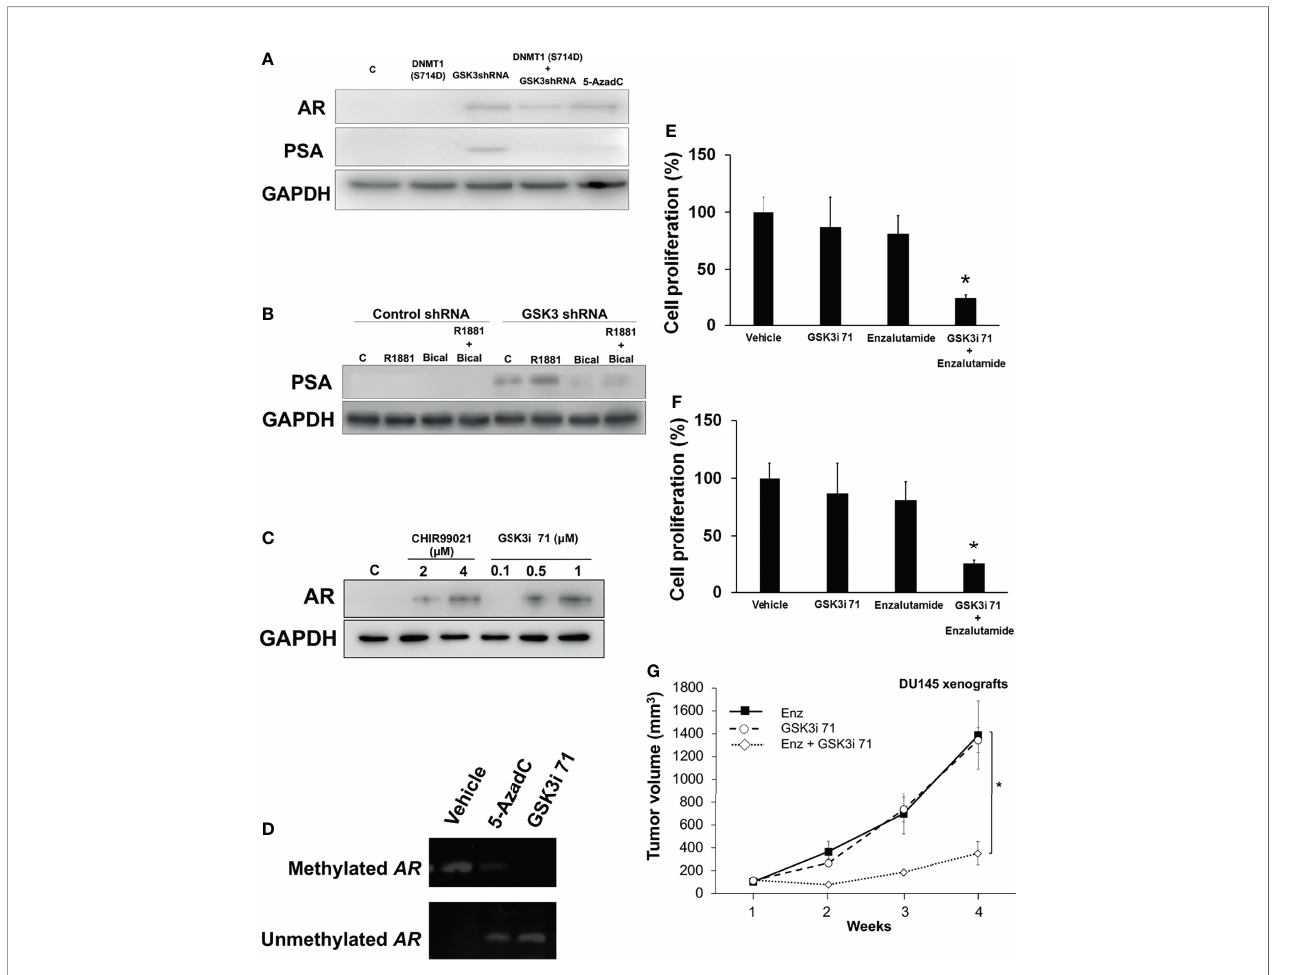
FIGURE 5 | GSK3 inhibition resulted in re-expression of AR and hormone dependence of an AR negative cell line. (A) DU145 cells were transfected with expression vector for DNMT1 (S714D) and/or GSK3 shRNAs targeting GSK3 a and GSK3 b and processed for western blot analyses of AR and PSA expression normalized to GADPH. Cells treated with 5-AzadC (5 µM for 48 h) were used as positive controls. Figures are representative of at least 3 independent experiments. (B) DU145 cells were transduced with control or GSK3 shRNA lentiviruses targeting GSK3 a and GSK3 b followed by puromycin selection. Some cells were treated with R1881 (5 nM, 4 h) and/or Bicalutamide (5 µM, 4 h). Cell were processed for western blot analyses of PSA expression normalized to GAPDH. Figures are representative of at least 3 independent experiments. (C) Cells were treated with indicated concentrations of GSK3 inhibitors. Cell were processed for western blot analyses of AR expression normalized to GAPDH. (D) DU145 cells were treated with vehicle, 5-AzadC (5 µM), or GSK3i 71 (500 nM) for 72 h Cells were harvested and genomic DNA extracted, followed by methylation-speci fi c PCR at the promoter region of the AR gene using bisul fi te-treated DNA. Figures are representative of at least 3 independent experiments. (E) DU145 cells were infected with control or GSK3 shRNA-containing lentiviruses targeting GSK3 a and GSK3 b followed by selection using puromycin and plating for cell proliferation. Some cells were treated with R1881 or Bicalutamide. (F) DU145 cells were treated with Enzalutamide (10 µM) and/or GSK3i 71 (500 nM). For (E, F) , after 5 days of treatment, WST-1 solution (10 mg/ml) was added to each well. The formazan crystals formed inside the viable cells were measured at 450 nm using a microplate reader. Figures are representative of at least 3 independent experiments *P <0.05 vs . GSK3 shRNA. (G) Male NSG mice were implanted with DU145 cells and treated Enzalutmide (30 mg/Kg), GSK3i 71 (10 mg/Kg), or a combination of both were administered by intraperitoneal injection daily for 4 weeks (5-6 mice/treatment group). *p < 0.01 relative to Enzalutamide- treated mice based on pairwise Student